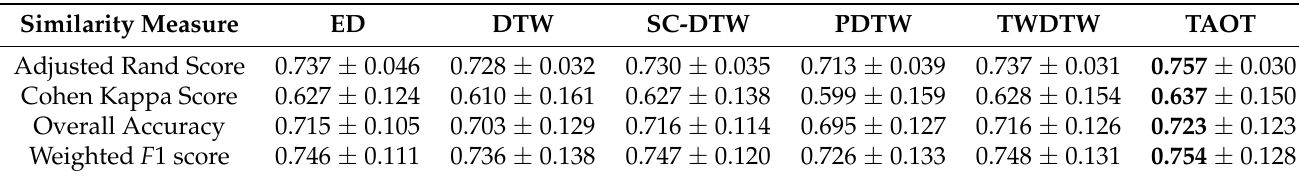
Table 6. Comparison of clustering performance on Poyang Lake dataset with random initial cluster centers. The best results are shown in bold.